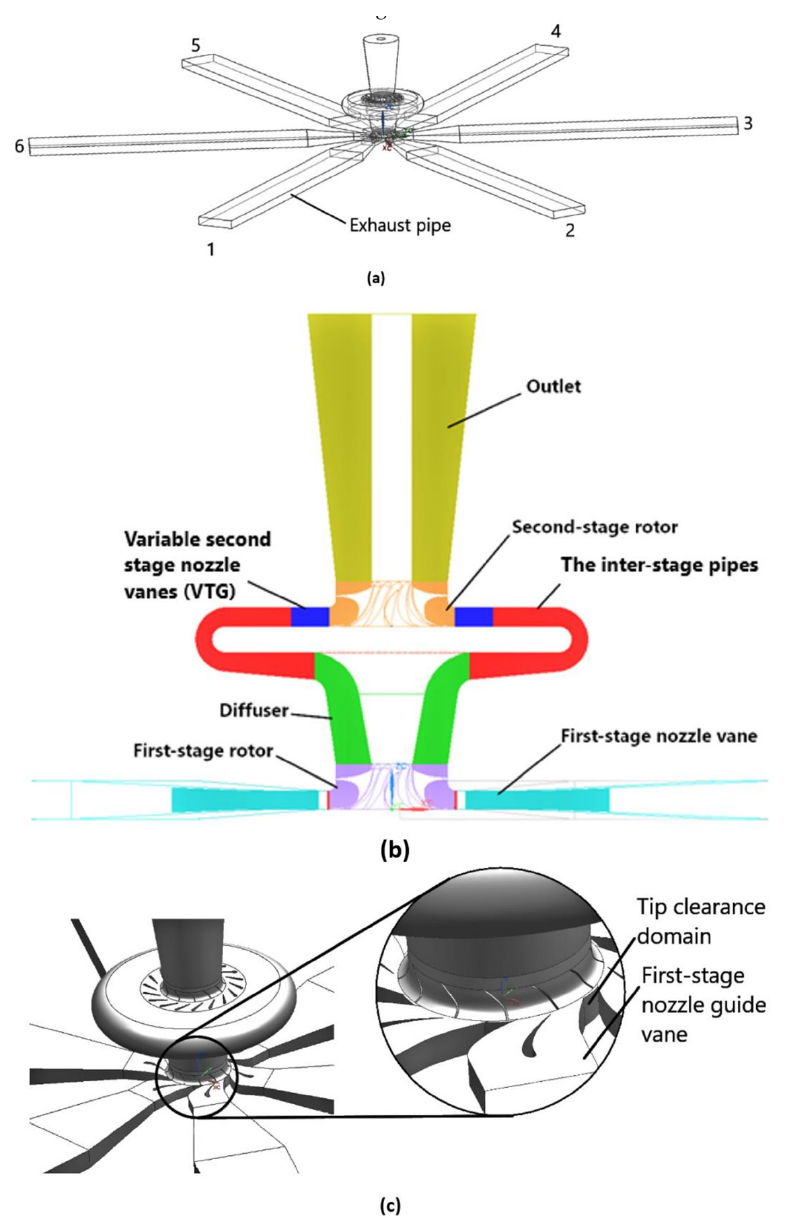
Figure 2. ( a ) The isometric view at the numerical model showing six exhaust pipes, ( b ) the model cross-section, ( c ) the view at the 1st stage nozzle vane and the tip clearance domain